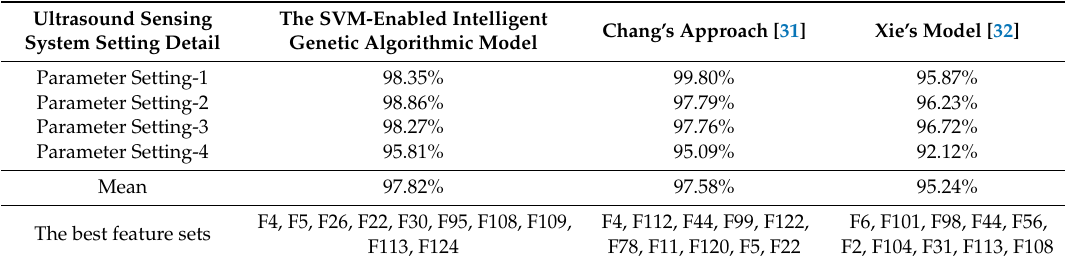
Table 18. Classification results of SVM-enabled intelligent genetic algorithmic model and peer approaches when chooses 10 features in each parameter